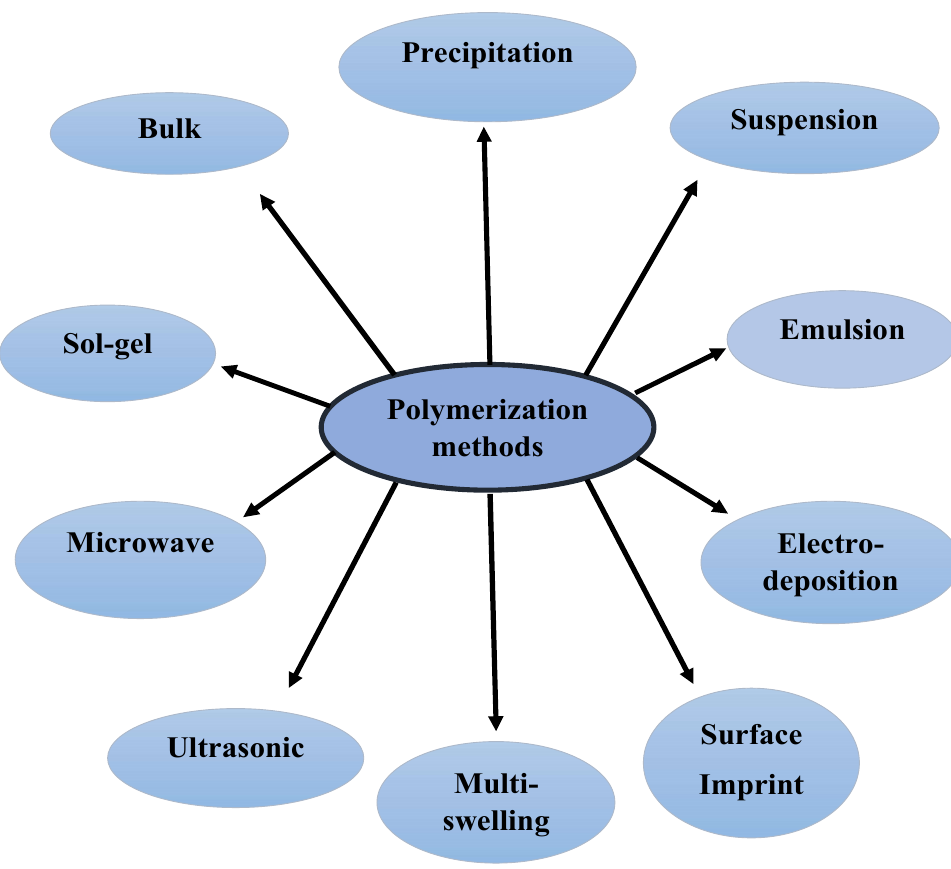
Figure 1. The most common polymerization methods used for MIP synthesis.